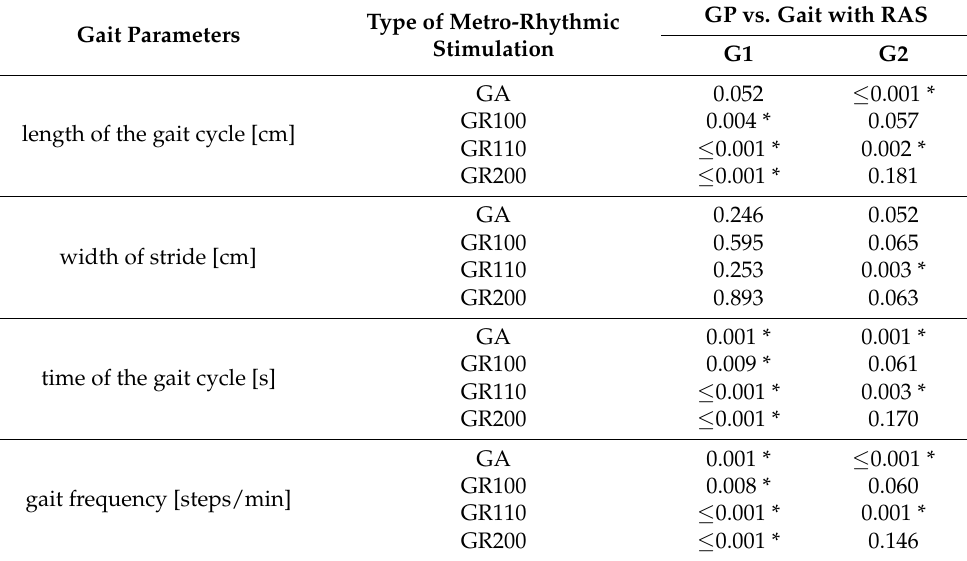
Table 3. Results of the Student’s t-test or the Wilcoxon test determining statistically significant differences between the results obtained in the GP test and the following tests with metro-rhythmic stimuli: GA, GR100, GR110, GR200.